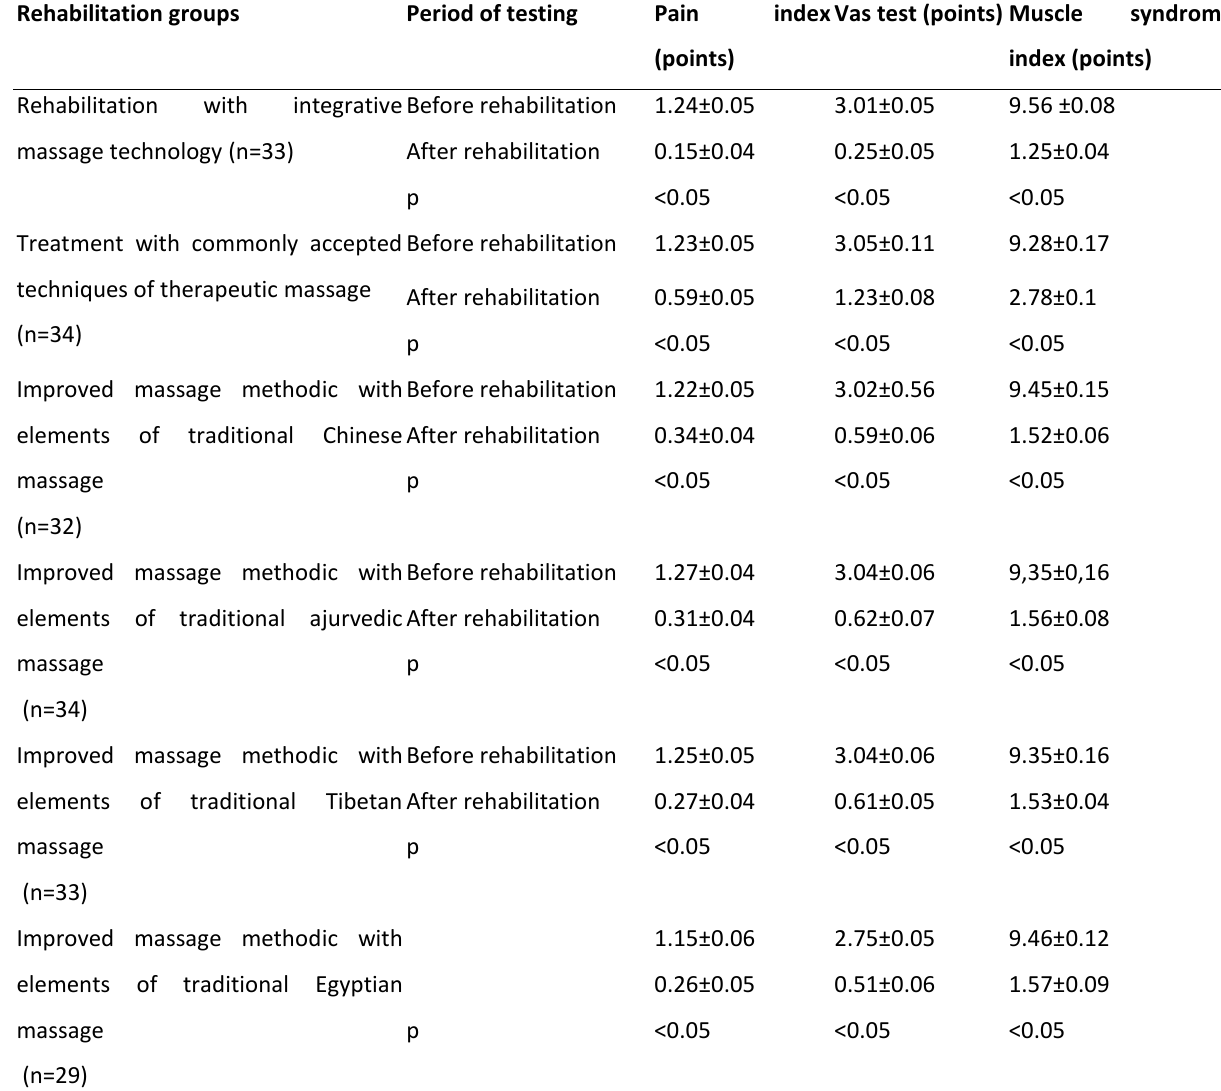
Table 3. Dynamic of integral indicators of backbone functional state (M±m) Rehabilitation